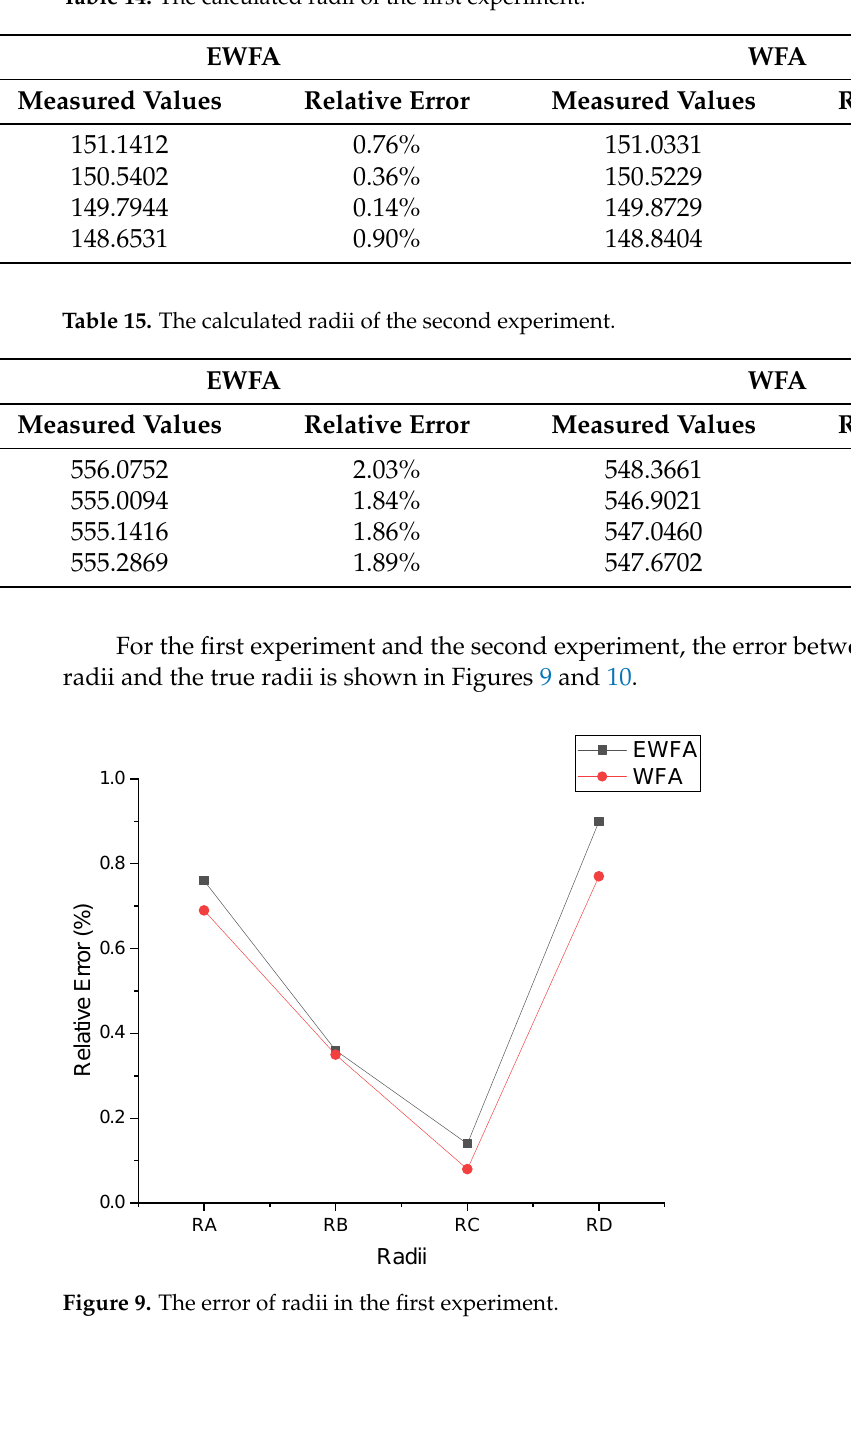
Table 14. The calculated radii of the first experiment.